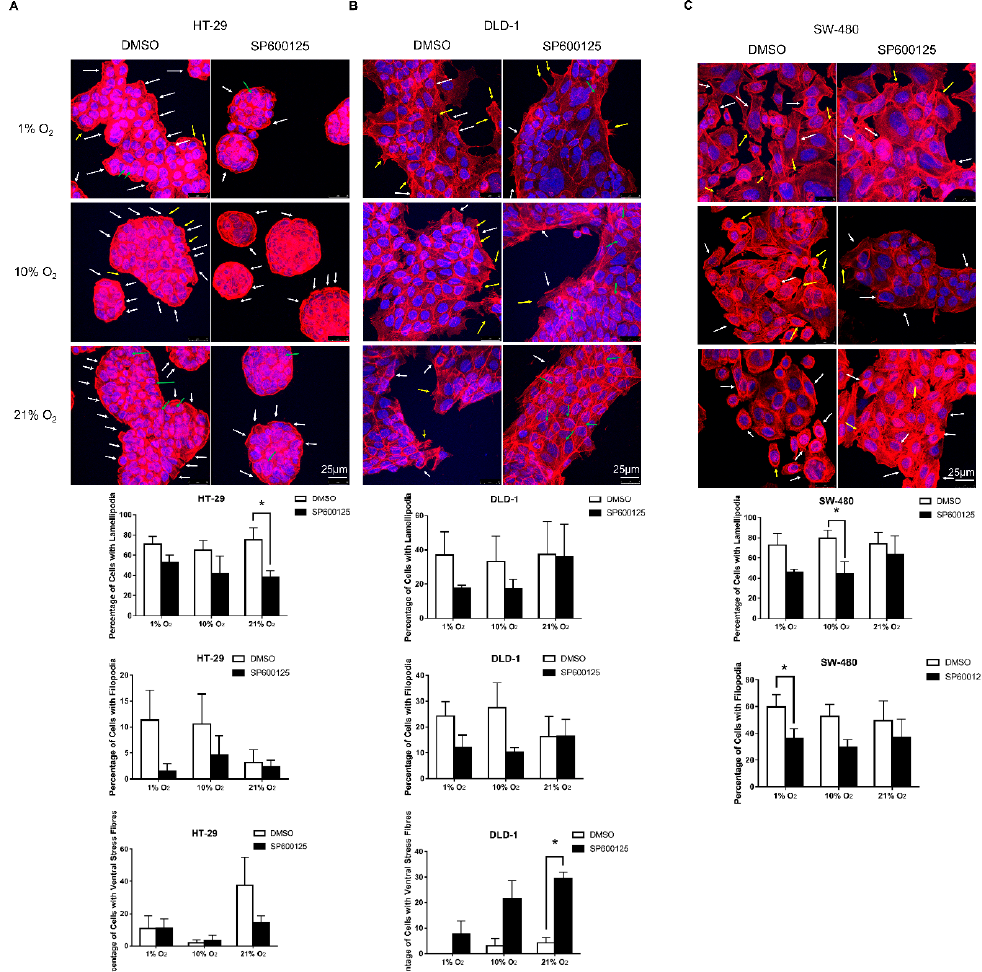
Figure 3. Immunofluorescence staining of F-actin under different oxygen levels. Immunofluorescence staining of F-actin (red) and DAPI (blue) showed an increase in filopodia formation (yellow arrows) and a decrease in ventral stress fiber formation (green arrows) in 1% and 10% O 2 conditions, while lamellipodia formation (white arrows) was similar among different oxygen levels in HT-29 ( A ) DLD-1 also showed an increase in filopodia formation in 1% and 10% O 2 with similar lamellipodia formation among different oxygen levels ( B ) SW-480 showed similar amounts of lamellipodia and filopodia formation among di ff erent oxygen levels, and ventral stress fibers were not observed in SW-480. ( C ) The presence of JNK inhibitor SP600125 slightly reduced filopodia and lamellipodia formation among the three cell lines, while ventral stress fiber formation was promoted in DLD-1. Sample images were taken from 3 independent experiments. The counting results were shown as means ± SEM in percentage among all evaluated cells. At least 200 cells were evaluated for each sample. * p < 0.05 DMSO versus SP600125. N =